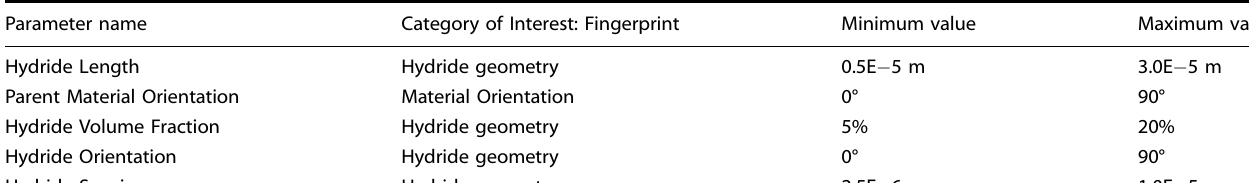
Table 2. Hydride microstructural distributions.